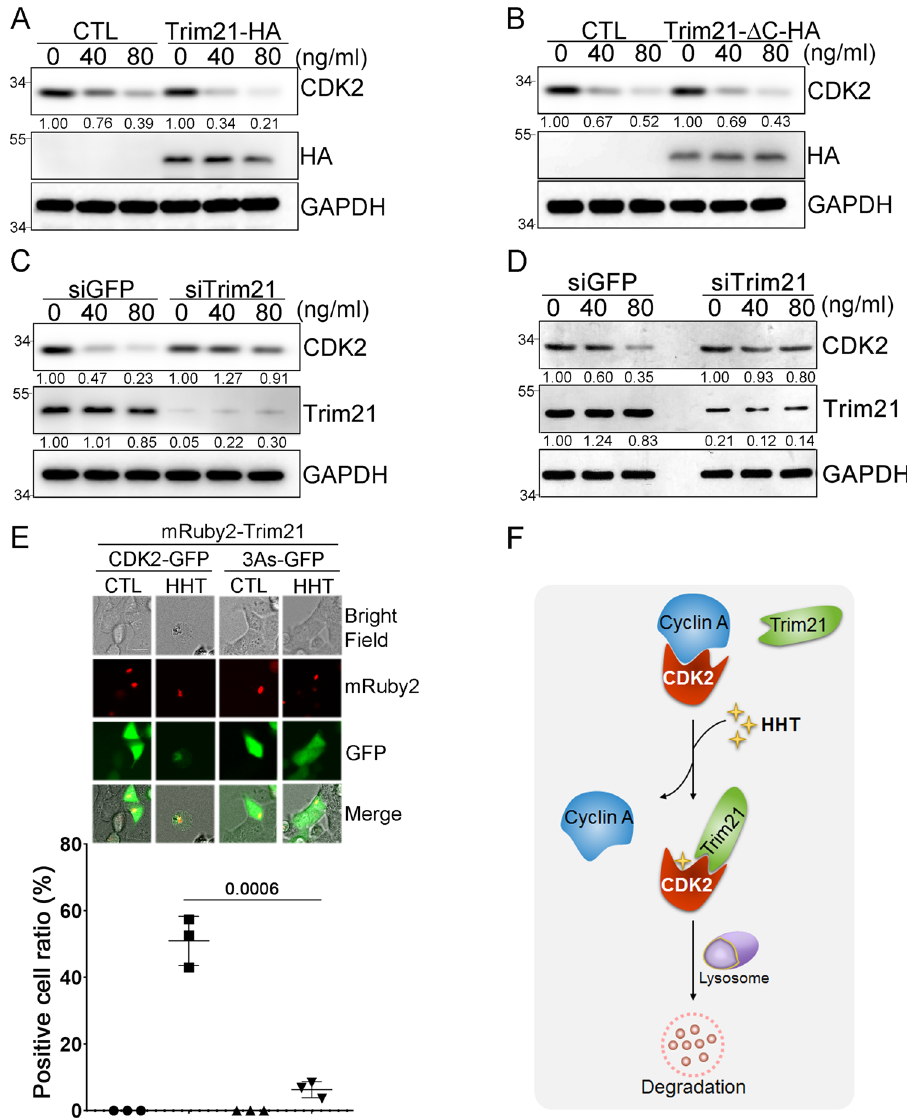
Fig. 6 Trim21-mediated CDK2 autophagic degradation in cancer cells. A THP1 cells transfected with either Trim21-HA plasmid or empty vector were treated with HHT as indicated for 9 hours, and the protein levels of CDK2 and Trim21 were analyzed by western blot with β -actin as the loading control. B THP1 cells transfected with either Trim21-HA- Δ C plasmid or empty vector were treated with HHT as indicated for 9 hours, and the protein levels of both CDK2 and Trim21 were analyzed by western blot with GAPDH as the loading control. C THP1 cells were transfected with siRNA targeting either Trim21 or GFP, and after 48 hours treated with HHT as indicated for 9 hours. The protein levels of CDK2 and Trim21 were analyzed by western blot with GAPDH as the loading control. D Mononuclear cells isolated from a primary AML patient were transfected with siRNA targeting either Trim21 or GFP. Forty-eight hours after transfection, cells were treated with HHT as indicated for 12 hours, and the protein levels of CDK2 and Trim21 were analyzed by western blotting with GAPDH as the loading control. E HEK293 cells were transfected with either CDK2-GFP or CDK2-3As-GFP as well as mRuby2-Trim21; then cells were either treated with HHT (50 ng/mL) or DMSO for 9 hours, and the localizations of CDK2 (green) and Trim21 (red) were determined by fl uorescence microscopy (upper panel). Scale bar, 20 μ m. The positive cell ratio with colocalization between CDK2-GFP and mRuby2-Trim21 after HHT treatment in three different experiment replicates was analyzed (lower panel). Data represent the mean ± SD from three independent biological samples for each group. P values are indicated by two-tailed unpaired Student ’ s t test. F A putative model of Trim21-mediated autophagic degradation of CDK2 protein induced by HHT. All the results shown here were representative of three independent experiments. Source data are provided as a Source data fi